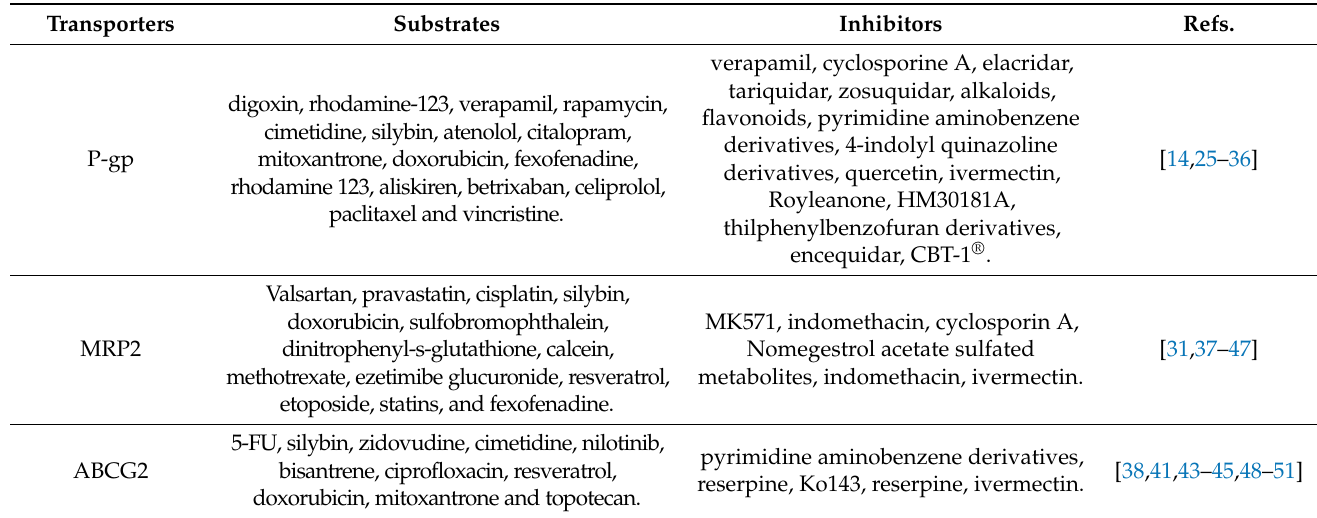
Table 1. Substrates and inhibitors of three main intestinal efflux transporters.